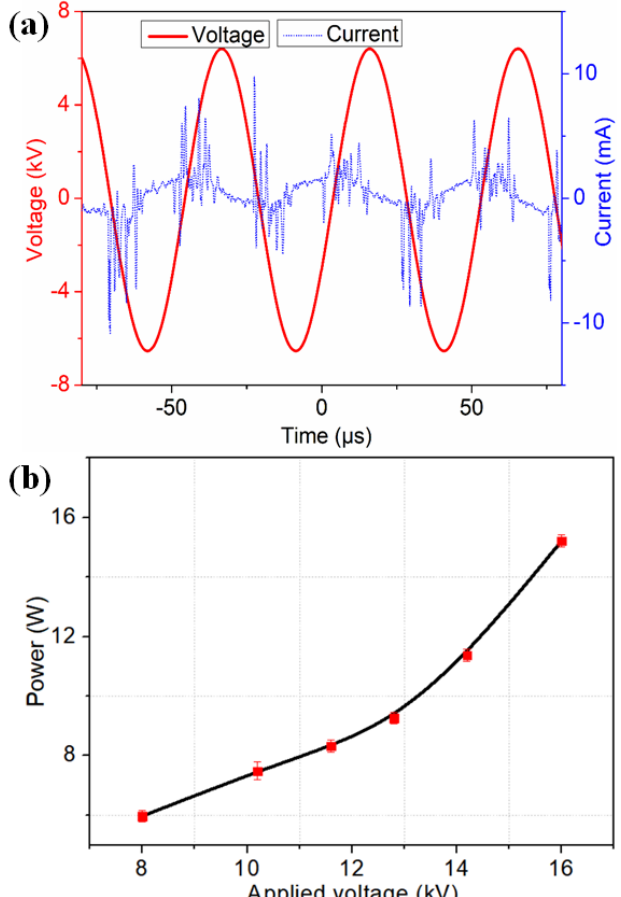
Figure 2. ( a ) Voltage–current discharge characteristics of Ar/H 2 O microplasma jet; ( b ) variation in dissipated power with different applied voltages.